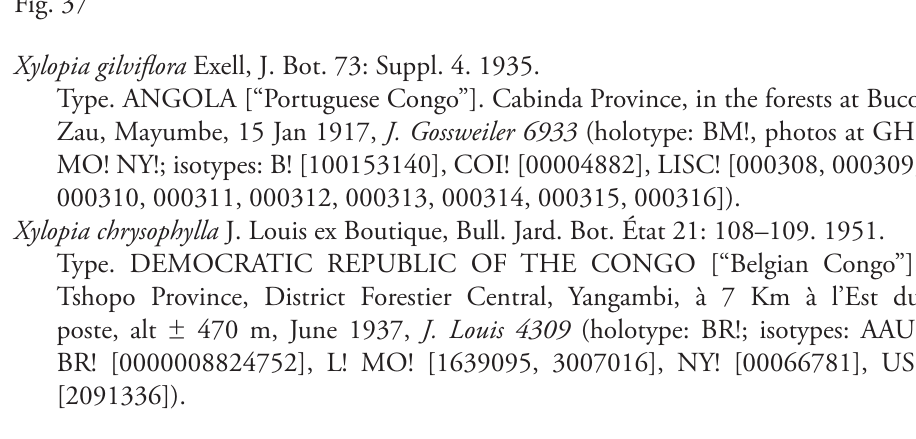
Xylopia gilviflora Exell, J. Bot. 73: Suppl. 4. 1935. Type. ANGOLA [“Portuguese Congo”]. Cabinda Province, in the forests at